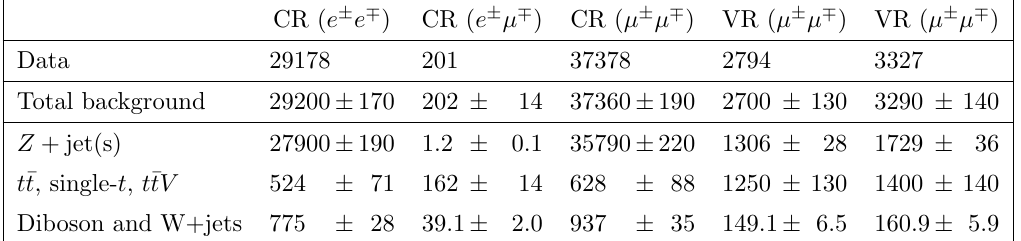
Table 5 . Numbers of expected background events in control and validation regions after the background-only (cid:12)t in the opposite-charge channel, compared to the data. The quoted uncertainties correspond to the total uncertainty in the predicted event yield including correlations between the various sources of systematic uncertainties. Due to rounding the total background can di(cid:11)er from the sums of components. Top-quark and Z + jet(s) yields are (cid:13)oating in the